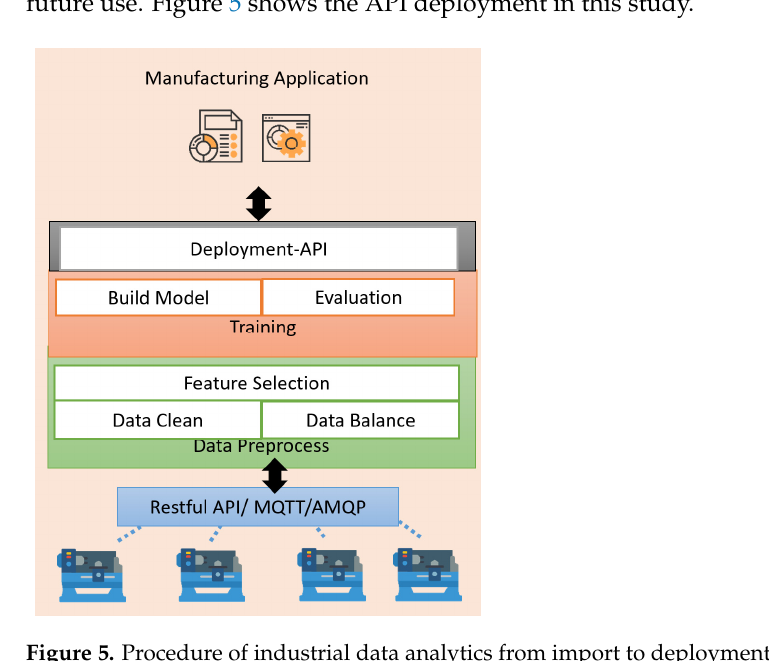
Figure 5. Procedure of industrial data analytics from import to deployment.